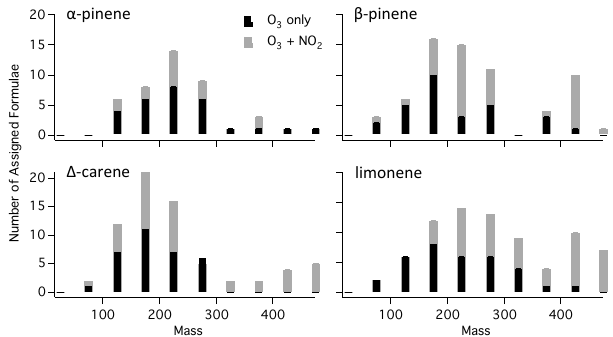
Figure 7. Histograms of each O 3 vs. NO 3 (O 3 + NO 2 ) regime for each monoterpene showing the number of compounds (left axis) in each 50 amu mass bin (bottom